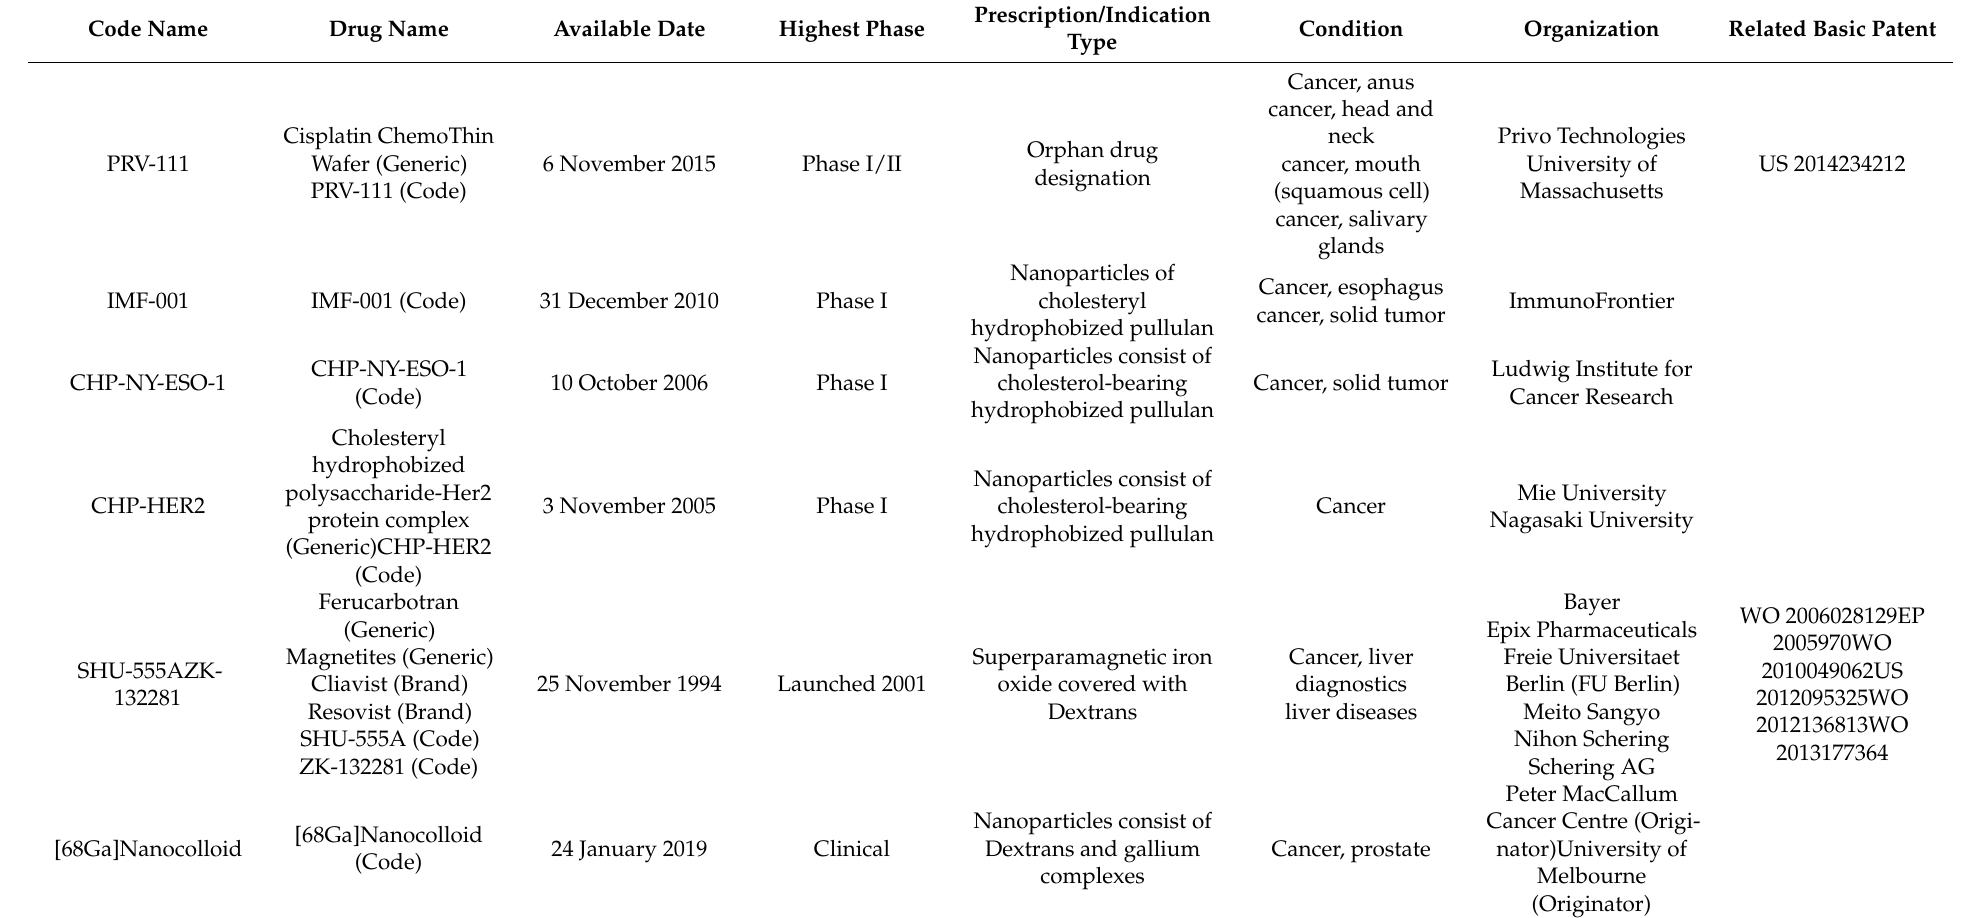
Table 1. The drugs used incorporating carbohydrate-based materials as scaffolds entering clinical